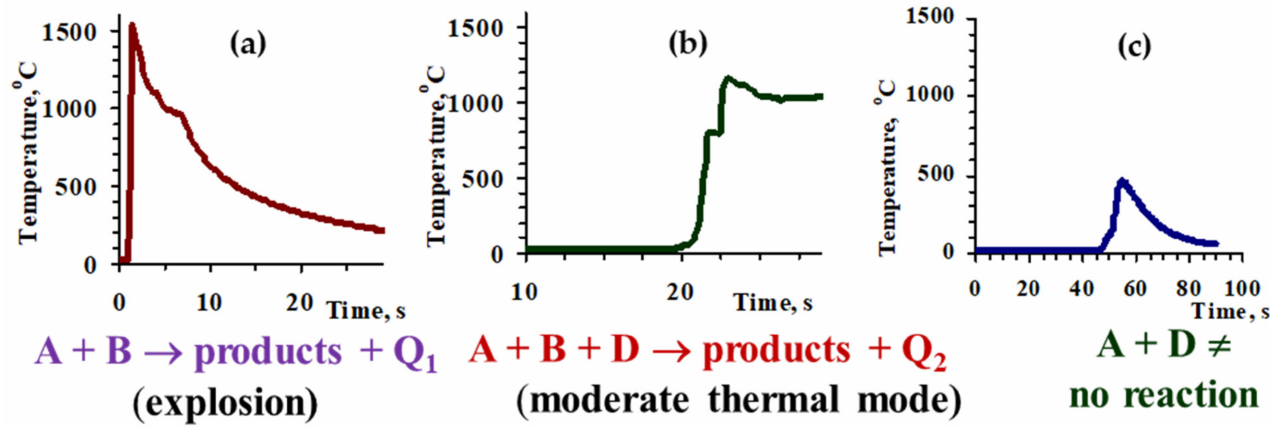
Figure 2. Combustion temperature profiles of the CuO + MoO 3 + 1.2Mg + xC mixtures, x = 0 ( a ), x = 5.0 ( b ), CuO + MoO 3 + C ( c ) (Q 1 and Q 2 are the amount of heat released). P N2 = 0.3 MPa.